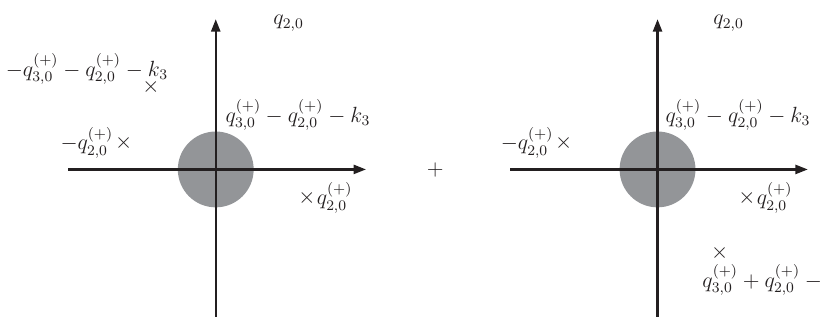
Figure 2 . Pole structure of the first residue of a rational function of two